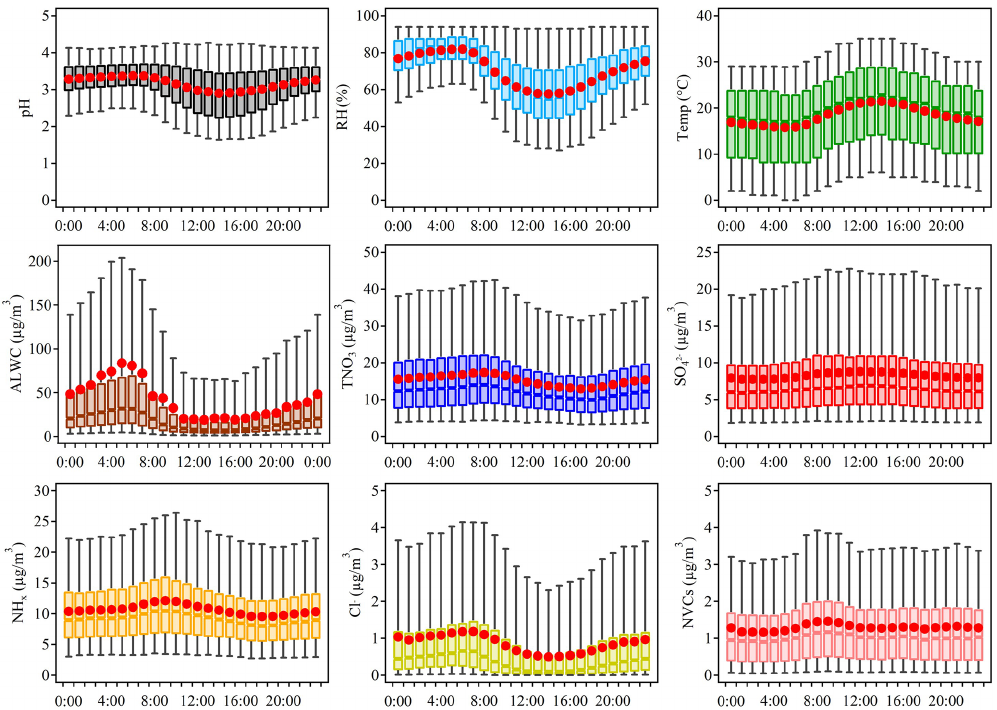
Figure 4. Diurnal variations of the mass concentrations of major ions in PM 2 . 5 , relative humidity (RH), temperature (Temp), predicted aerosol liquid water content (ALWC) and aerosol pH during 2011–2019 in Shanghai.